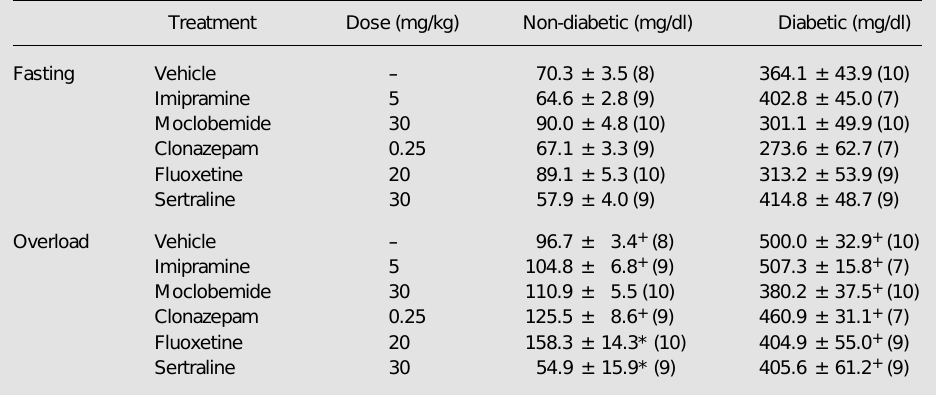
Table 1 - Fasting glycemia and glycemia measured 60 min after a glucose overload in diabetic and non-diabetic rats treated with different